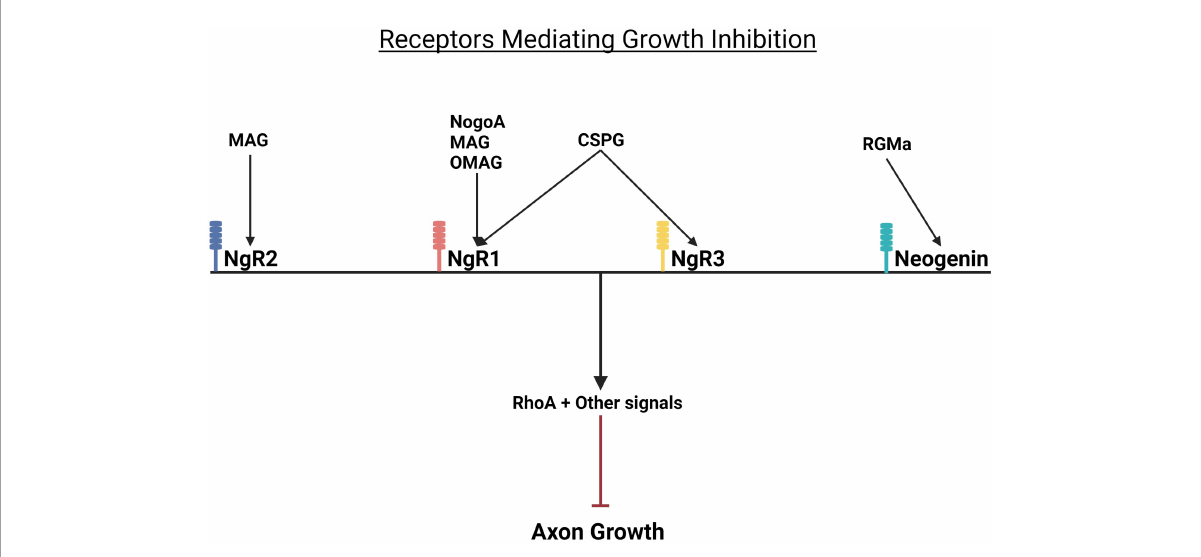
FIGURE4 Growth repressive molecules and their receptors. Growth inhibition by CSPGs and myelin proteins is mediated by Nogo receptors. While CSPGs bind to the Nogo receptors NgR1 and NgR2, myelin inhibitors (MAG and OMgP) bind to NgR1 and NgR2. RGMa binds to its receptor neogenin. When activated, all these receptors trigger the activation of RhoA and consequent inhibition of axon growth. NgR, Nogo receptor; MAG, myelin associated glycoprotein; OMgP, oligodendrocyte myelin glycoprotein; CSPG, chondroitin sulfate proteoglycan; RGMa, repulsive guidance molecule